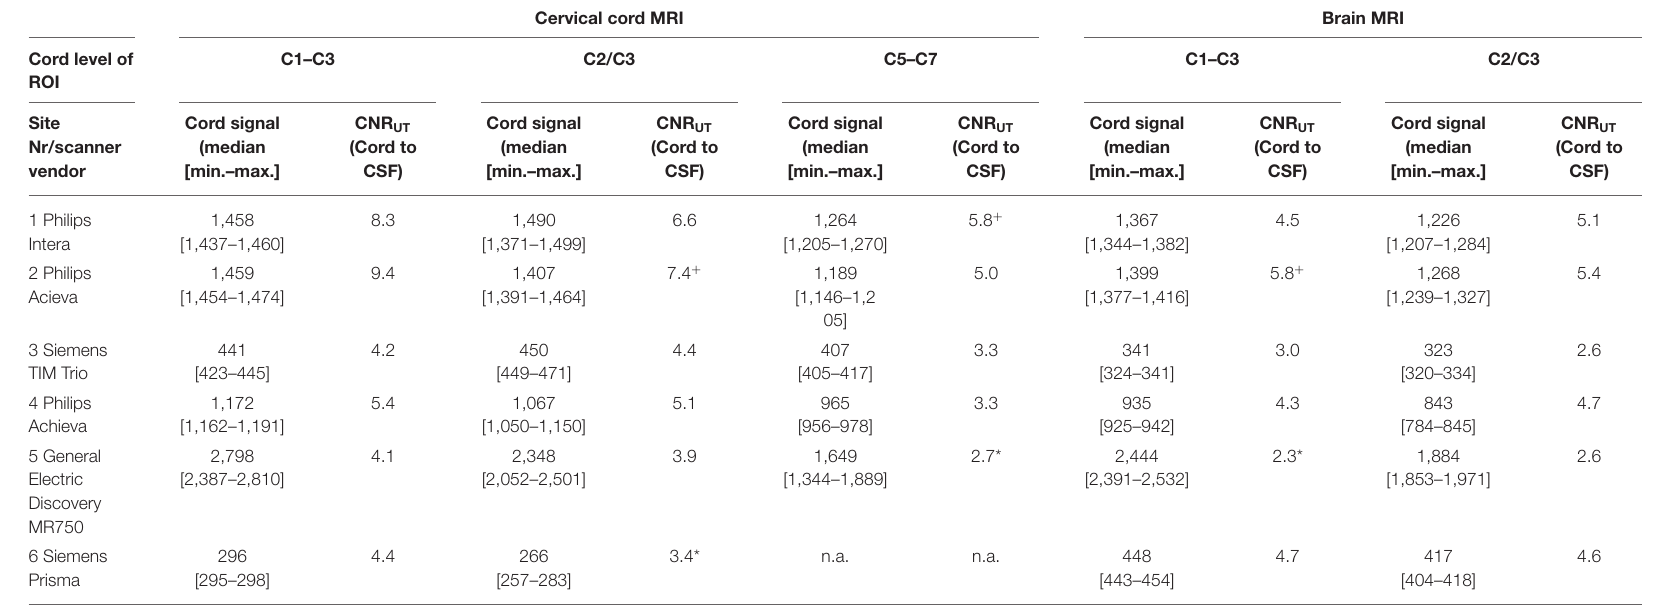
Cord signal within region of interest in arbitrary units (a.u.); CNR UT (Cord to CSF): contrast-to-noise ratio per unit of time, expressed as the mean of three repeated MRIs; contrast-to-noise ratio per unit of time )/mean (standard deviation of cord and CSF) * 1/sqrt(t), with t Significant pairwise differences between centers (Kruskal–Wallis tests with post-hoc pairwise comparisons using Bonferroni-corrected Dunn’s tests): * p < 0.050,